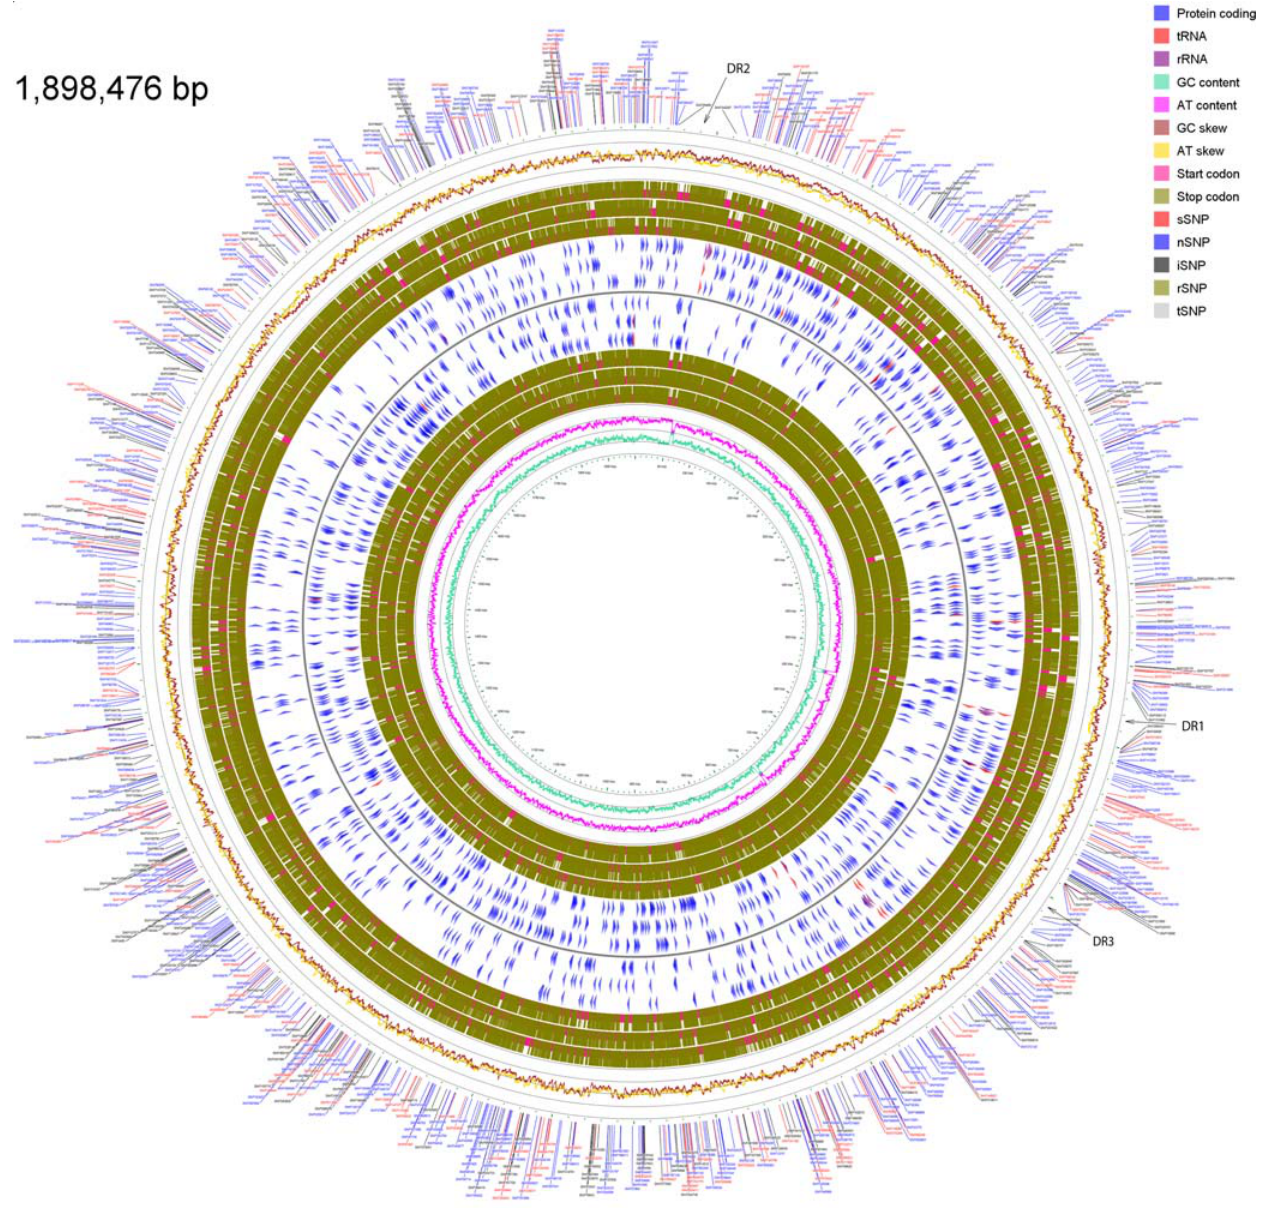
Figure 1. Circular genome diagram of the Francisella tularensis subsp. tularensis WY96 genome. The layers beginning with the outermost layer depict: the location and types of SNPs found between WY96 and Schu S4, a line graph depicting AT and GC skew throughout the genome, the locations of start and stopcodons inthe forwardthreereadingframes,ORFlocations intheforwardthreereadingframes,ORFlocations inthe reversethree readingframes, start and stop codons in the reverse three reading frames, and a line graph depicting AT and GC content throughout the genome. The SNP positions are relative to the Schu S4 genome (Table S2), and are classified as synonymous (sSNP), non-synonymous (nSNP) and intergenic (iSNP), ribosomal (rSNP), and tRNA (tSNP). SNPs in duplicated regions (Table S5) are not shown here, but in Figure 4. Figure created using CGView